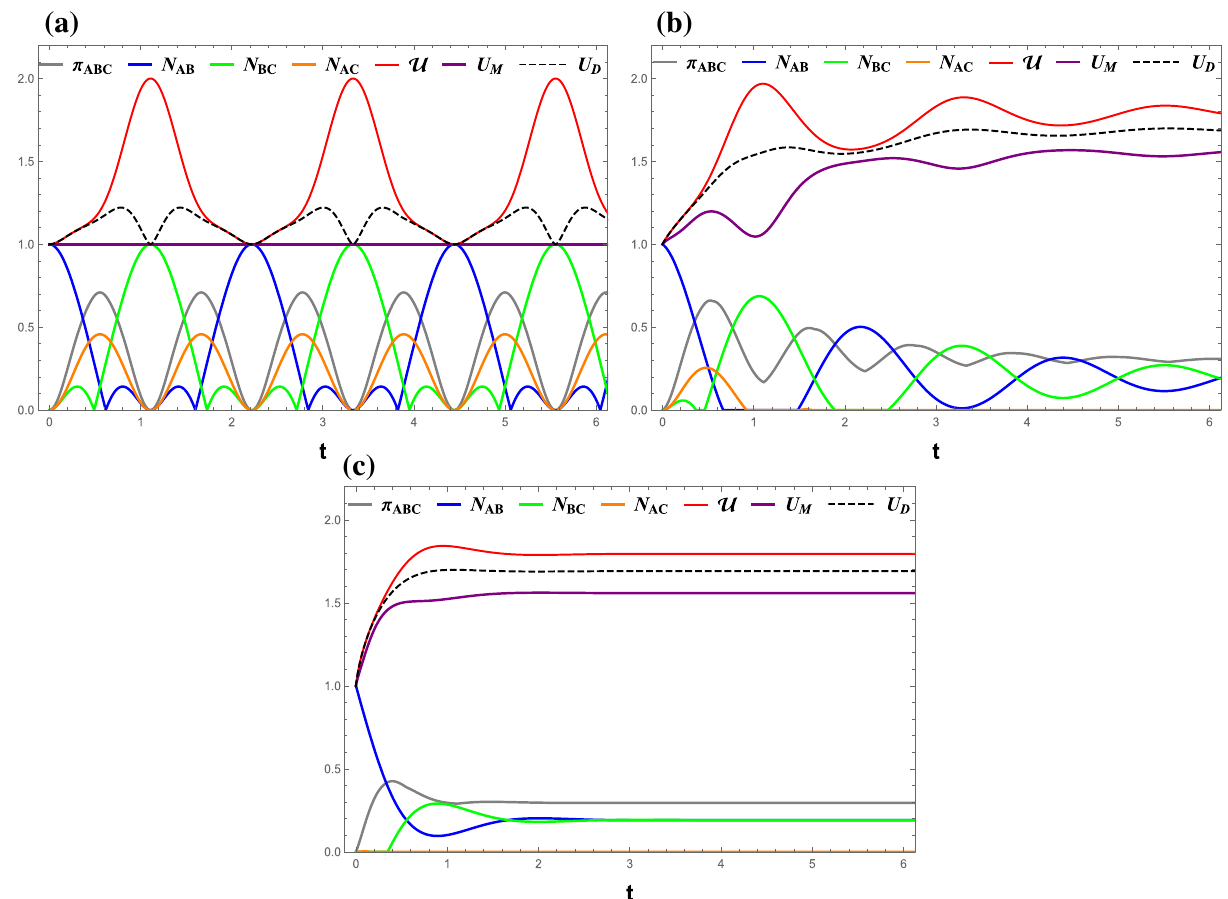
Figure 4. (Color online) Time evolutions of U (red line), U M (purple line), U D (black dashed), π ABC (gray line), N AB (blue line), N BC (green line), and N AC (orange line) under the measurement ( σ x , σ y ). ( a ) γ = 0, ( b ) γ = 0.1, and ( c ) γ = 0.5 All Figs. J z = 0, B =